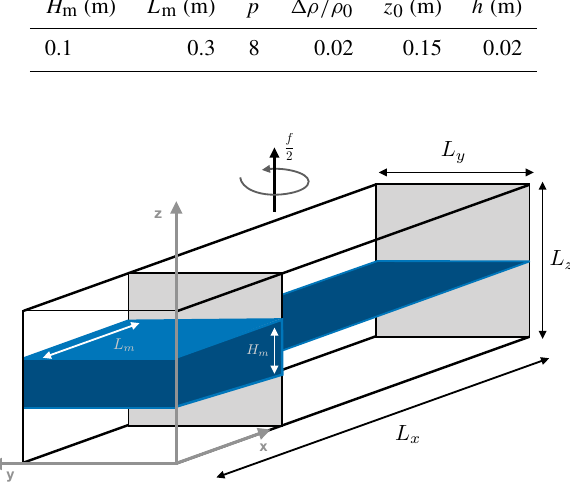
Figure 1. Schematic of the numerical domain. The blue region, cen- tred at the mid-depth, corresponds to ρ = ρ 0 , with heavier fluid be- low and lighter fluid above. All lengths have the units of metres and the rotation rate has the units of s − 1